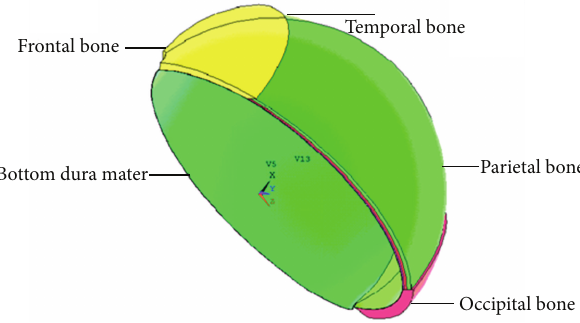
Figure 10: 3D model of 1/2 cranial cavity.